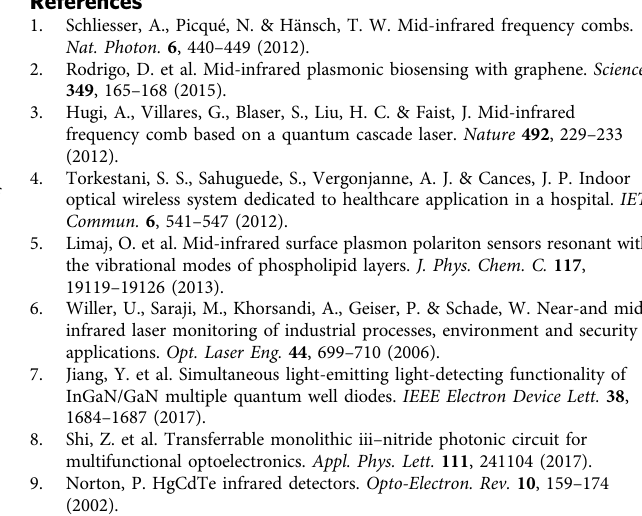
Fig. 4 Bidirectional MIR communication system using two identical GFs. a Block diagram of the prototype of the bidirectional MIR communication system. Receiving and transmitting sides of the system can write/read MIR data into the system by encoding/decoding transmitting messages into binary codes. b The dependence of current transfer ratio (CTR) of GF on the increasing input current, I in at various working distance (0.3 – 3 cm). The dependence of output current, I out , on the increasing of F applied to the GF emitter ( c ), and on the selection of fi lters ( d ) the GF – GF communication system. e Downstream and upstream transmissions. Details of signal processing are present in the Methods section. In IR images, “ E ” refers to the GF emitter and “ R ” refers to the GF receiver. f The electric signals of E are stably digitized in the system. Electrically driven GF transmits a signal of binary code “ 1 ” , and GF in the dormant state represents a signal of “ 0. ” g The communication currents per input electrical fi eld, I* , of state-of-the-art MIR sensors in bidirectional MIR communications. h MIR communication between two GFs reaches 100 KHz without the interference of signal processing